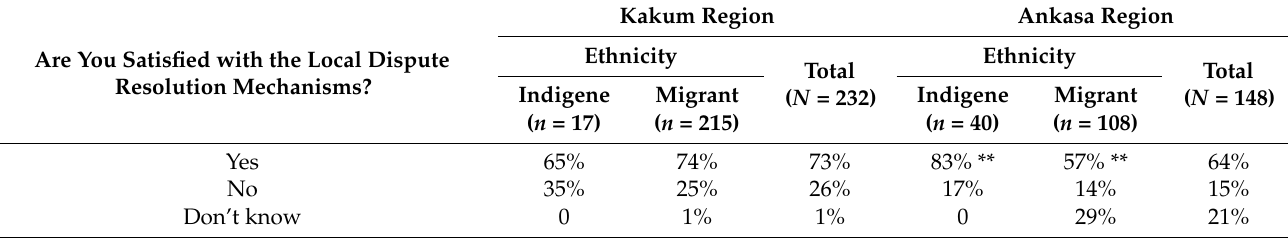
Table 4. Satisfaction with local dispute resolution mechanisms by